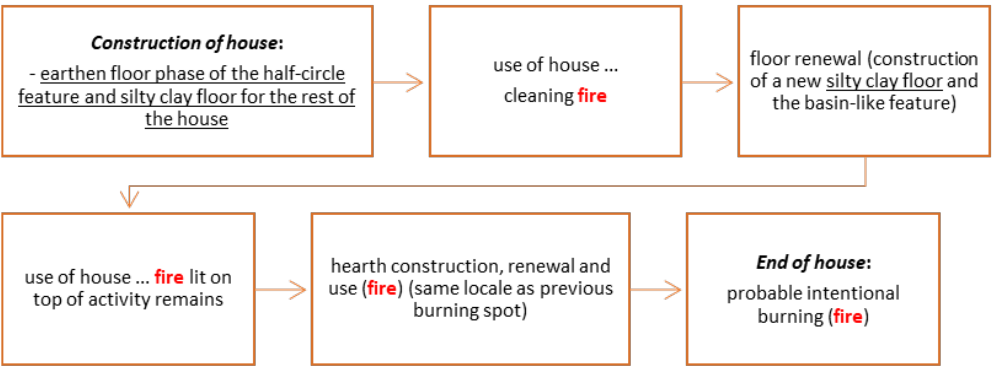
Figure 11. Lifecycle of house ID 3497 and related burnings.